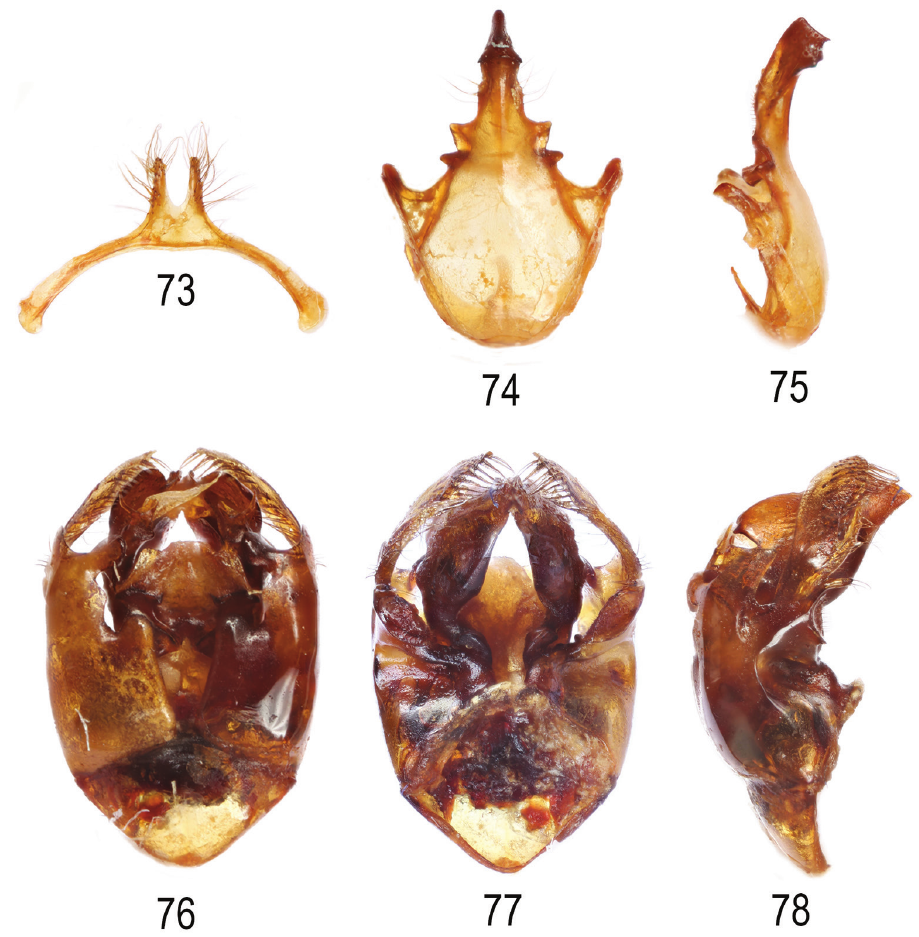
Figures 73–78. Male terminalia of E. simillima (paratype. Mexico: Chihuahua, Barranca del Cobre, KUNHM-ENT 0504566). 73 Seventh metasomal sternum in ventral view 74, 75 Eighth metasomal sternum in ventral and lateral views 76–78 Genital capsule in dorsal, ventral, and lateral